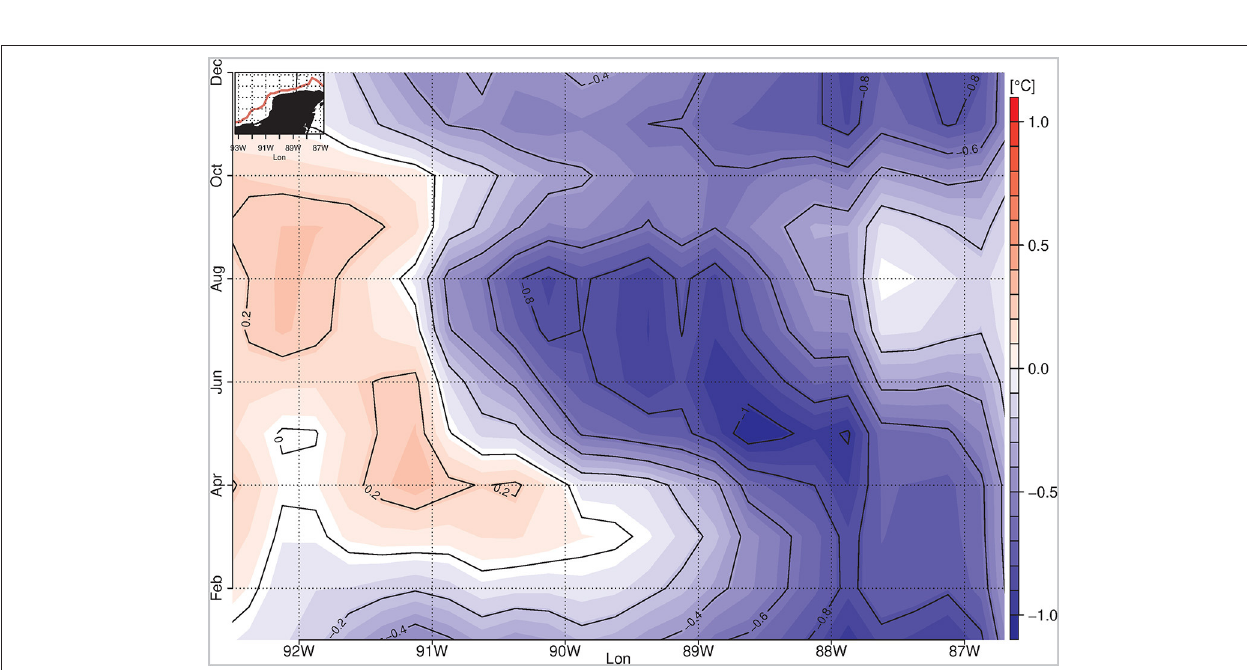
FIGURE 9 | Hovmöller diagram of the monthly averaged remotely sensed SST anomalies. Red (blue) color shows warmer (colder) temperatures than the 39 years spatial-temporal mean (1981–2020). The transect used for the calculations is in the top left (in red).